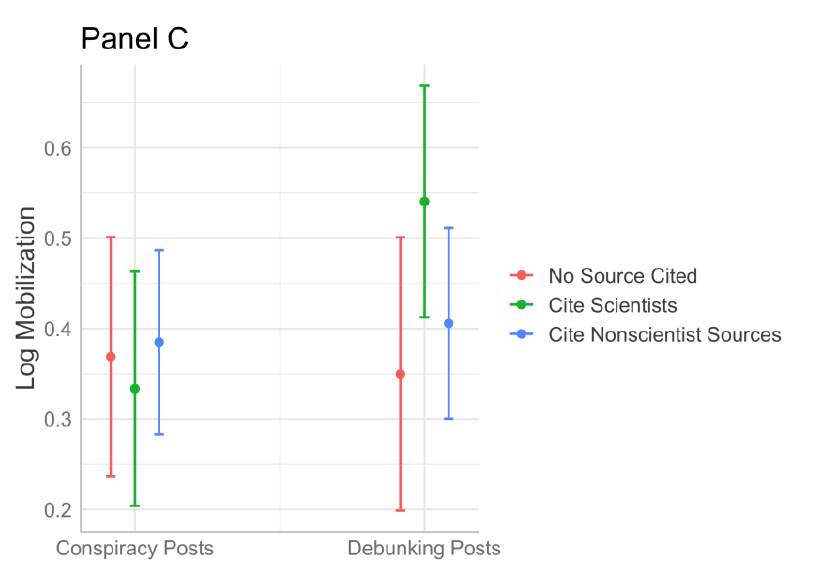
Figure 4. How user gender (A), number of followers (B) and source cited (C) moderate the associations between debunking posts and user participation and mobilization. A 95% confidence interval for the marginal effect of the interaction terms on our dependent variables from the OLS regression are plotted. We took the log form for our dependent variables, participation and mobilization, accounting for their skewed distributions. We took the log form for our independent variable the number of followers. For panel B, when log (number of followers) = 0, the intercept of participation for conspiracy posts is -0.53 and the intercept of participation for debunking posts is -0.65. For details on the full regression results, please see Appendix